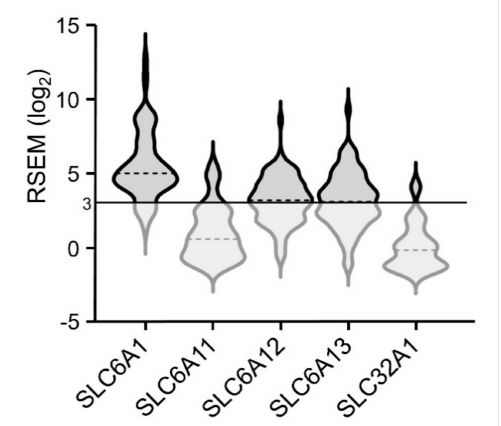
Figure 9. Expression of transcripts encoding GABA transporters; dotted lines represent median expression levels.